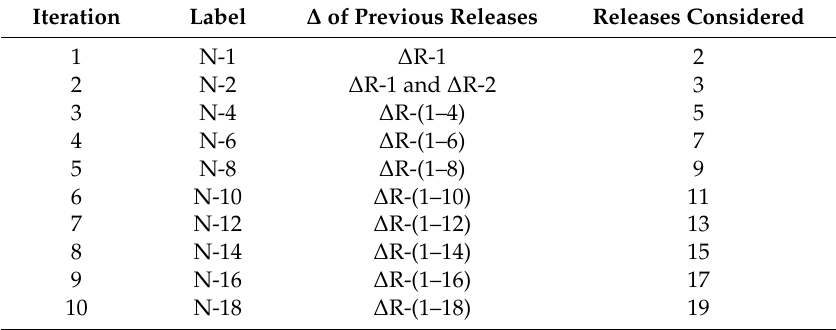
Table 5. Details about iterations of the